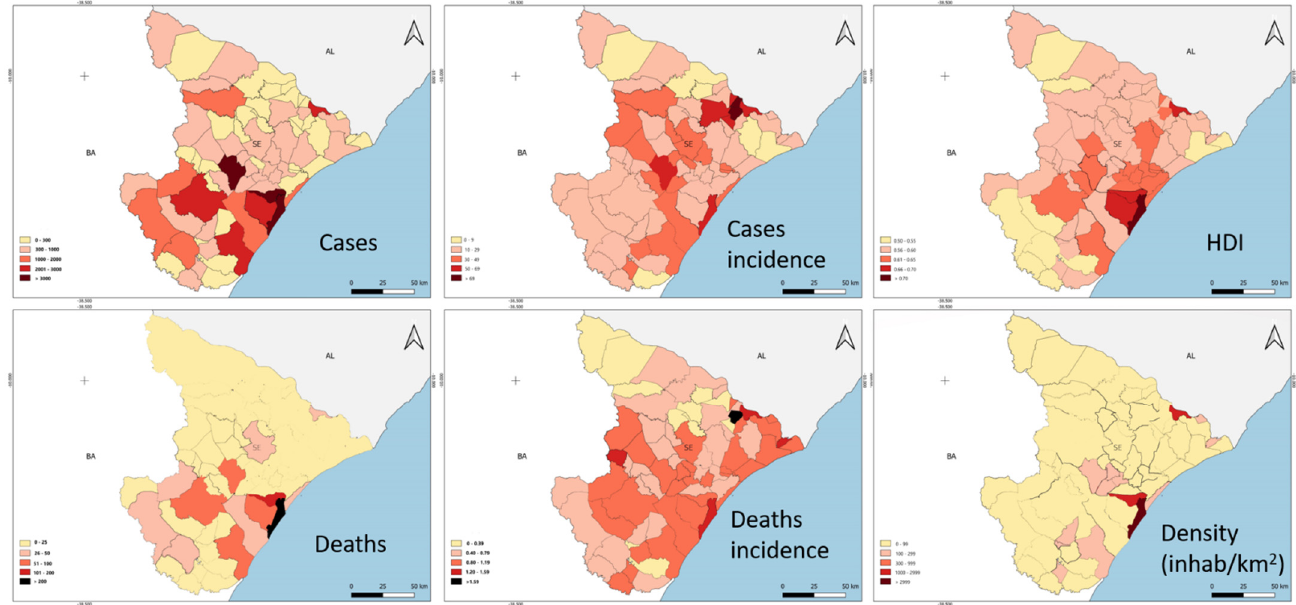
Figure 3. COVID-19 territorial distribution in the State of Sergipe, Brazil, from April to October 2020. Case number, case incidence per 1000 inhabitants, HDI, death number, death incidence per 1000 inhabitants and density (inhabitants/km 2 ).